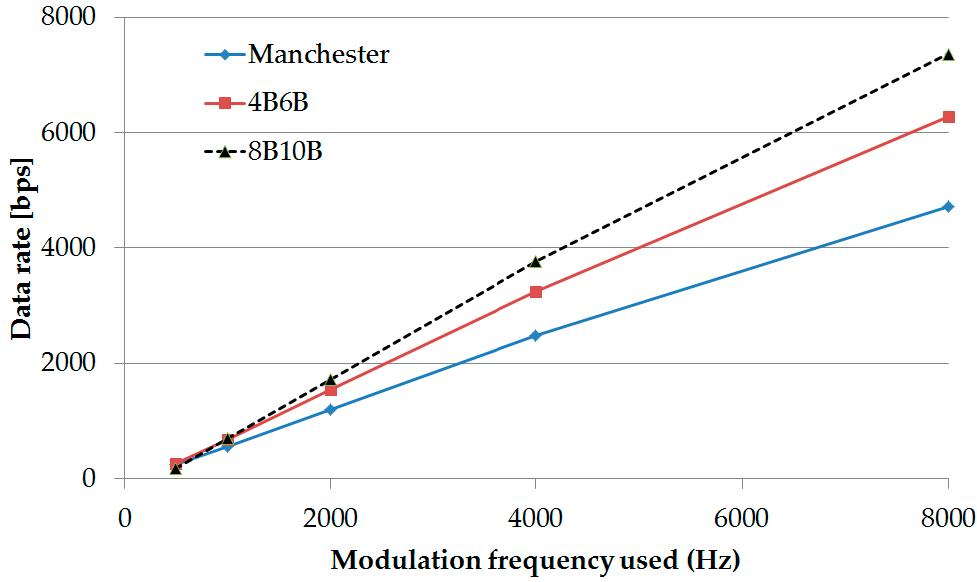
Figure 16. An estimation of data rate limit (free-error) in the available frequency range. See Equation (6) for calculation.